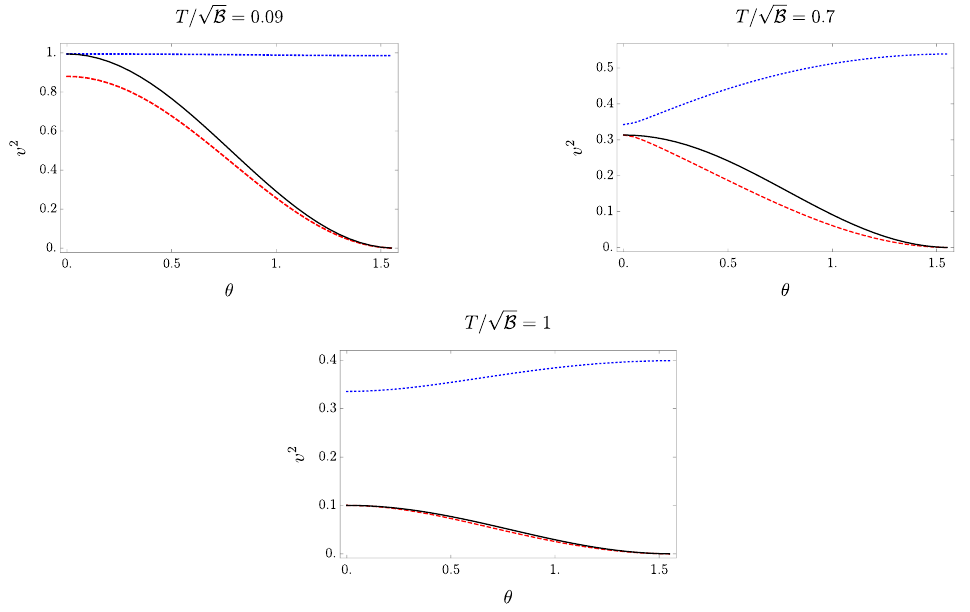
Figure 5 . Angular dependence of the speeds of Alfv(cid:19)en (black, solid), fast (blue, dotted) and slow (red, dashed) magnetosonic waves in the strong-(cid:12)eld, the crossover and the weak-(cid:12)eld regimes. in(cid:12)nitesimally small value of momentum k , and follow from (cid:12)rst expanding the polynomial (cid:6) vk (cid:0) i D k 2 . The speeds v (presented in (cid:12)gure 5) and attenuation coe(cid:14)cients D